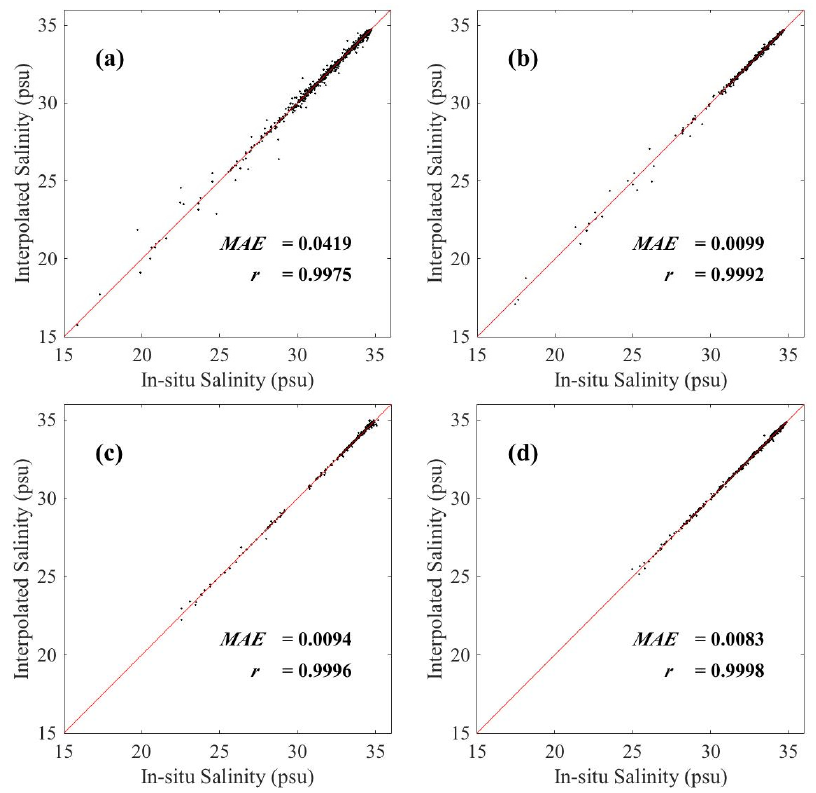
Figure 6. Scatterplots of the matchups between the interpolated and in situ salinity. The red line is the 1:1 line and 𝑟 is the correlation coefficient. ( a ) Summer 2010; ( b ) Summer 2011; ( c ) Autumn 2010; and ( d ) Autumn 2011.